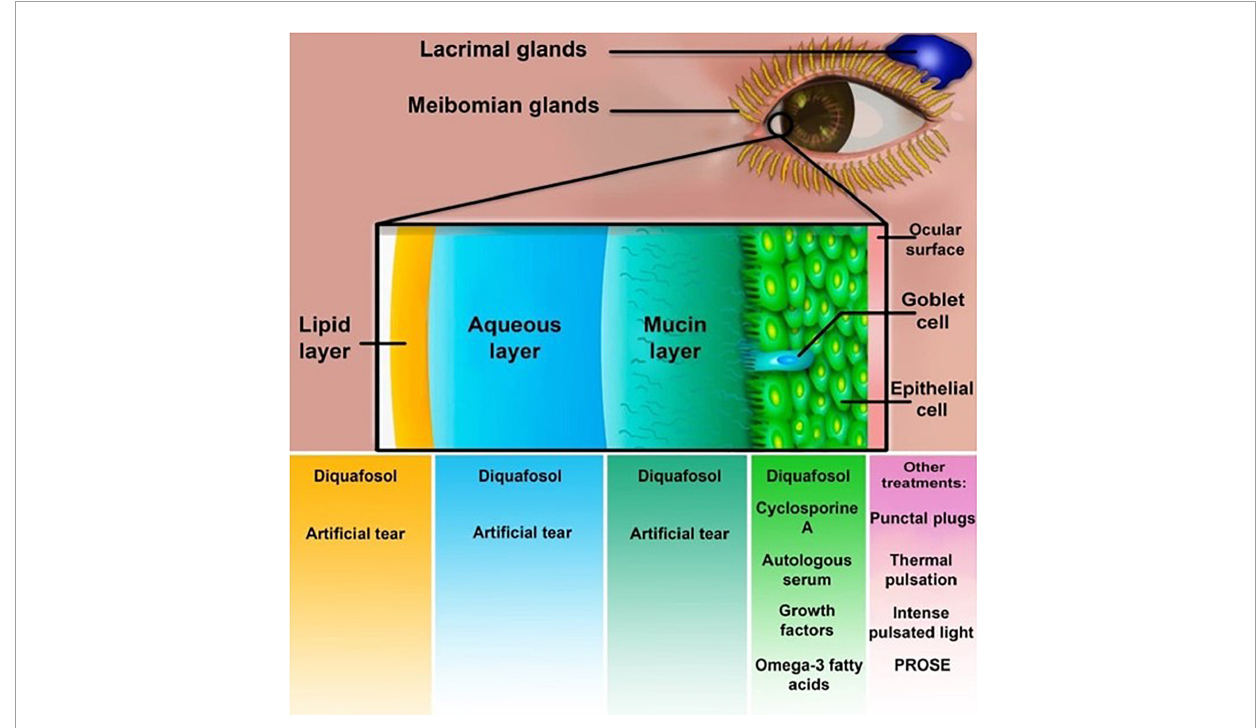
FIGURE1 Treatment methods for post-laser-assisted in situ keratomileusis (LASIK) dry eye syndrome. Cyclosporine A, diquafosol, artificial tears, autologous serum, growth factors, and omega-3 fatty acids are dry eye disease (DED) treatments affecting different layers of the tear film. Punctual plugs, thermal pulsation, and prosthetic replacement of the ocular surface ecosystem (PROSE) are other treatment